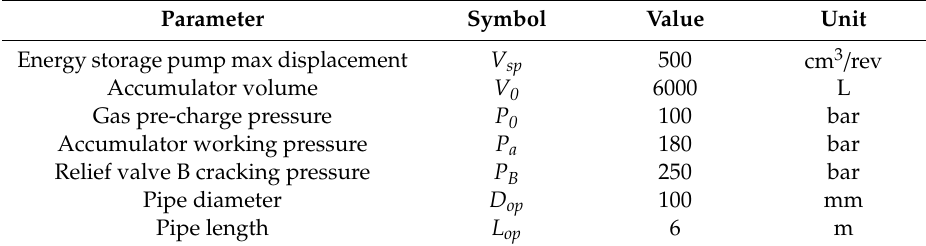
Table 3. The parameters of the hydraulic energy storage.